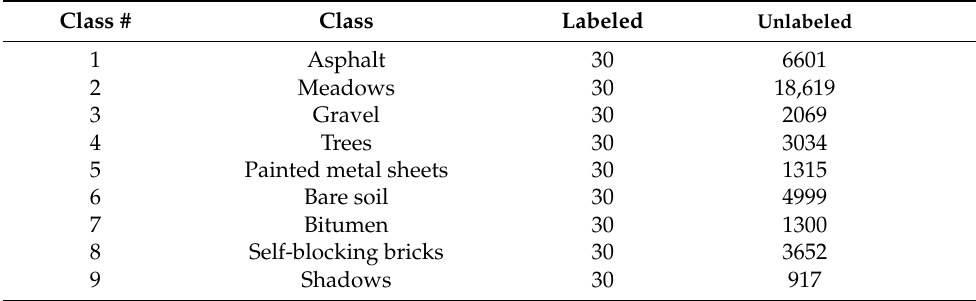
Table 2. Numbers of labeled and unlabeled samples for the University of Pavia